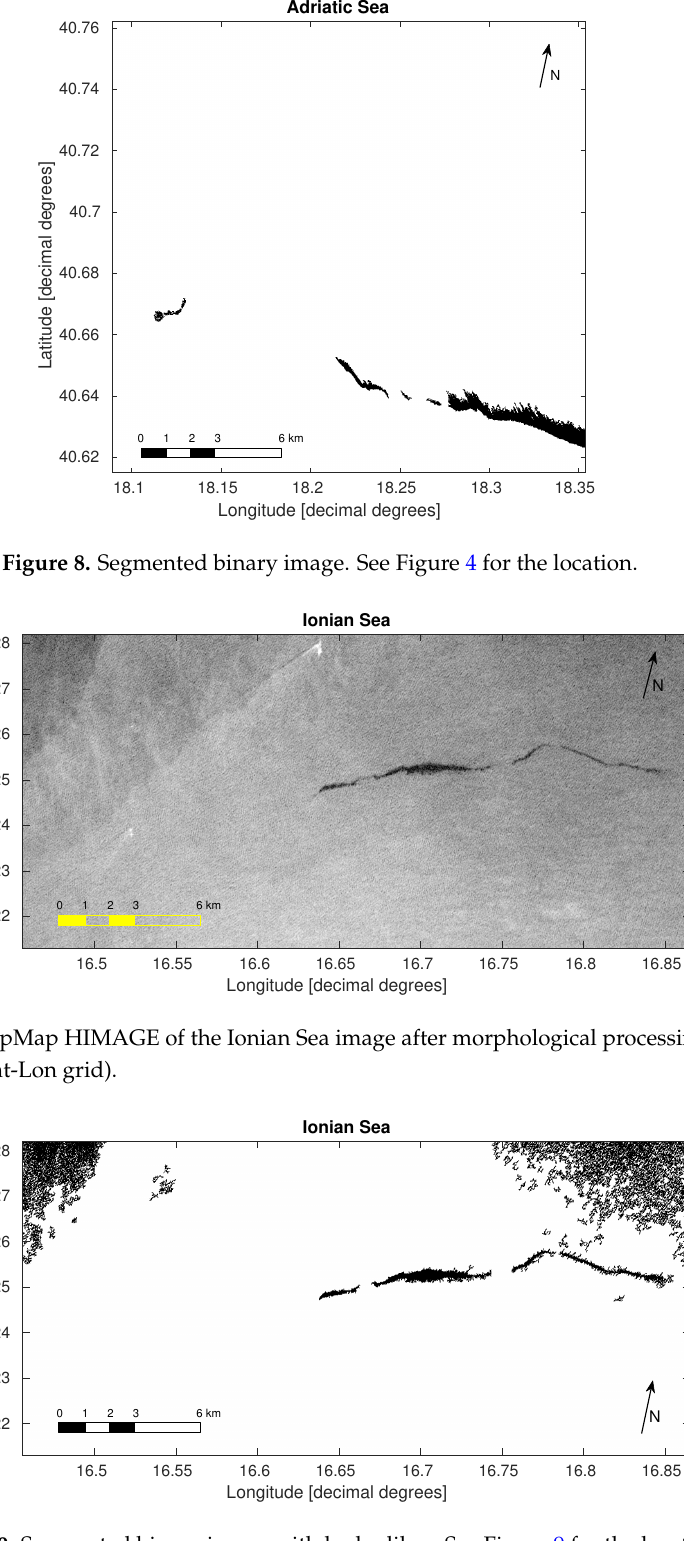
Figure 10. Segmented binary image with look-alikes. See Figure 9 for the